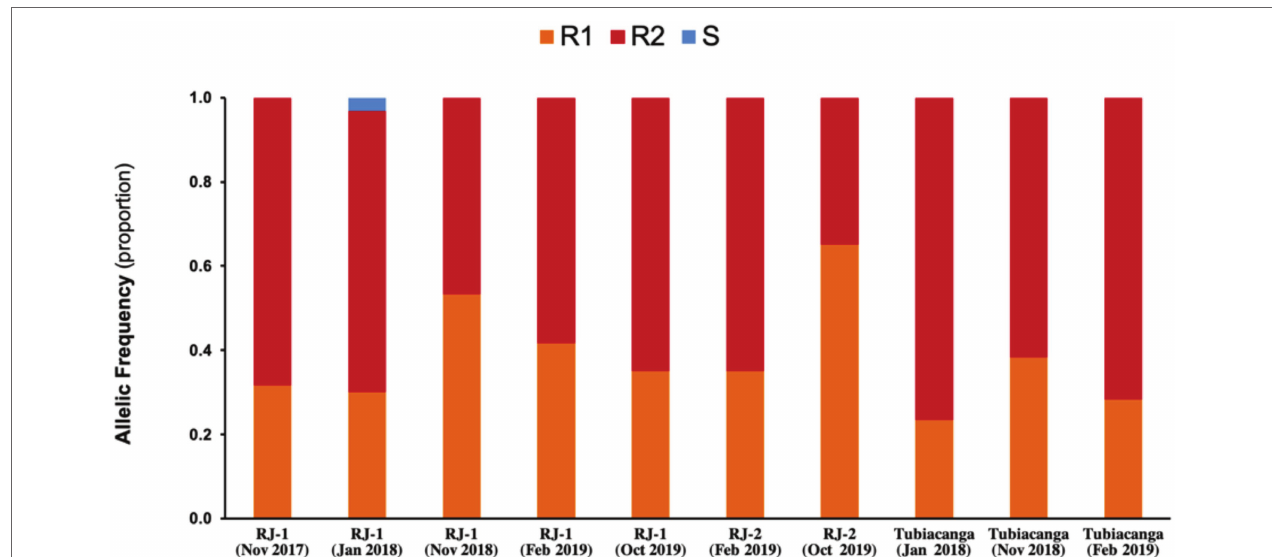
FIGURE 5 | Genetic monitoring of insecticide resistance in intervention areas. Knockdown resistance ( kdr ) allelic variants were monitored in field caught mosquitoes ( Wolbachia + ) over the release and post-release interventions in RJ1 and RJ2. Data represent the proportion of alleles linked to susceptibility, S, or resistance to insecticides, R1 and R2, in each sample ( n = 30). Mosquitoes from Tubicanga, home to a previous successful trial, were also included for comparison. S ( NavS ): 1016Val + ; R1 ( NavR1 ): 1016Val + , 1534Cys kdr ; R2 ( NavR2 ): 1016Ile kdr , 1534Cys kdr